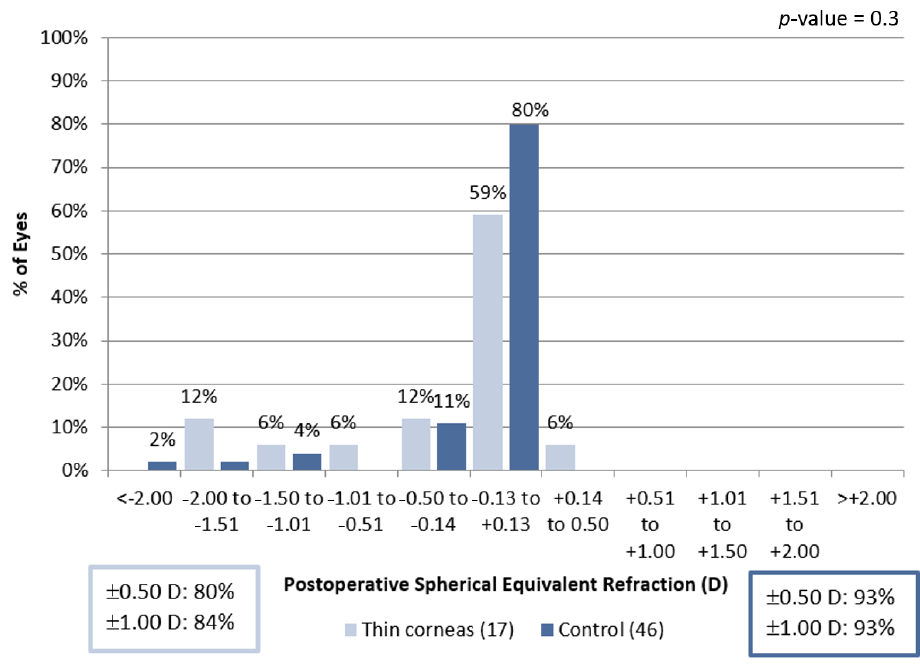
Figure 3. Correlation of attempted and achieved spherical equivalent depending on baseline cornea thickness at 3 months ( left ) and 6 months ( right ). Notes: analysis was performed for 27 and 44 eyes at 3 months, and 17 and 46 eyes at 6 months, for the “thin corneas” and control groups, respectively. Green lines represent 95% confidence interval, pink lines indicate 95% prediction interval. We found no significant difference in spherical equivalent refractive accuracy at 6 months (Figure 4).